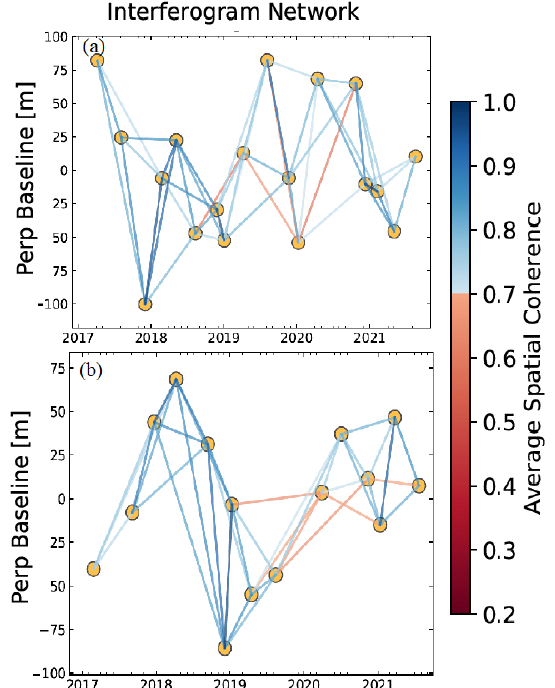
Figure 2. The SBAS networks of the used datasets. (a) Path 28, (b) Path137. Each black point represents one image of data. The connected graph between every two points depicts one interferometric pair, whose color demonstrates the moderate coherence of the corresponding